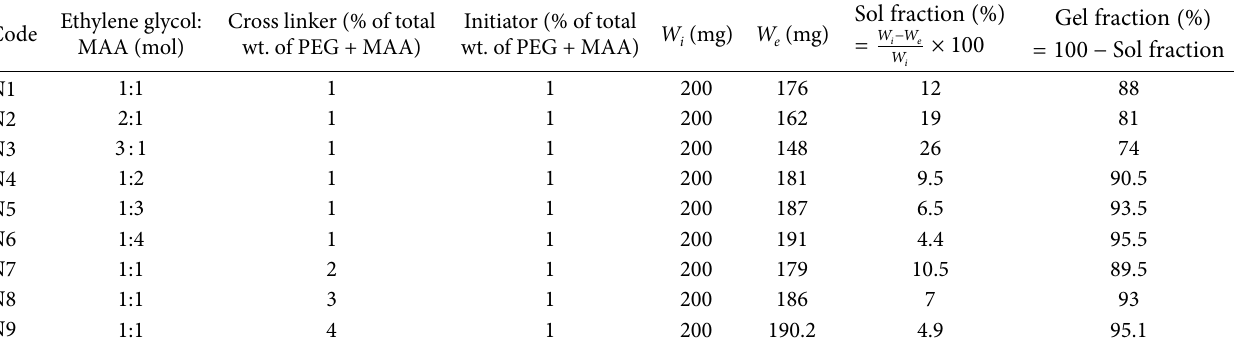
Table 1: Composition of PEG-g-poly (MAA) nanogels and calculation of sol–gel fraction. Ethylene glycol: Cross linker (% of Code MAA (mol)